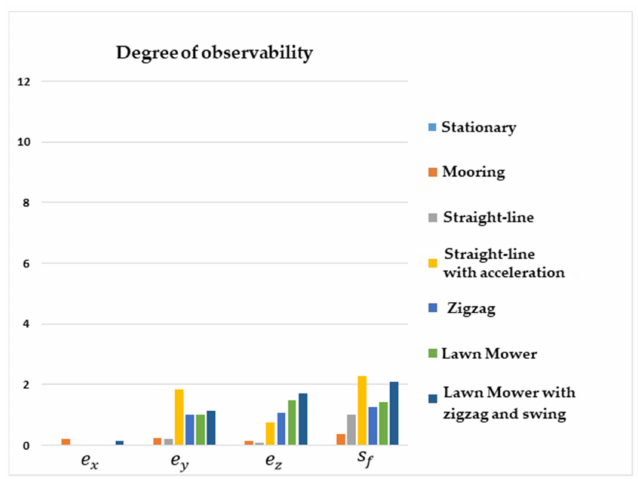
Figure 12. Degrees of observability of the IMU/DVL misalignment and the DVL scale factor error. INS/DVL